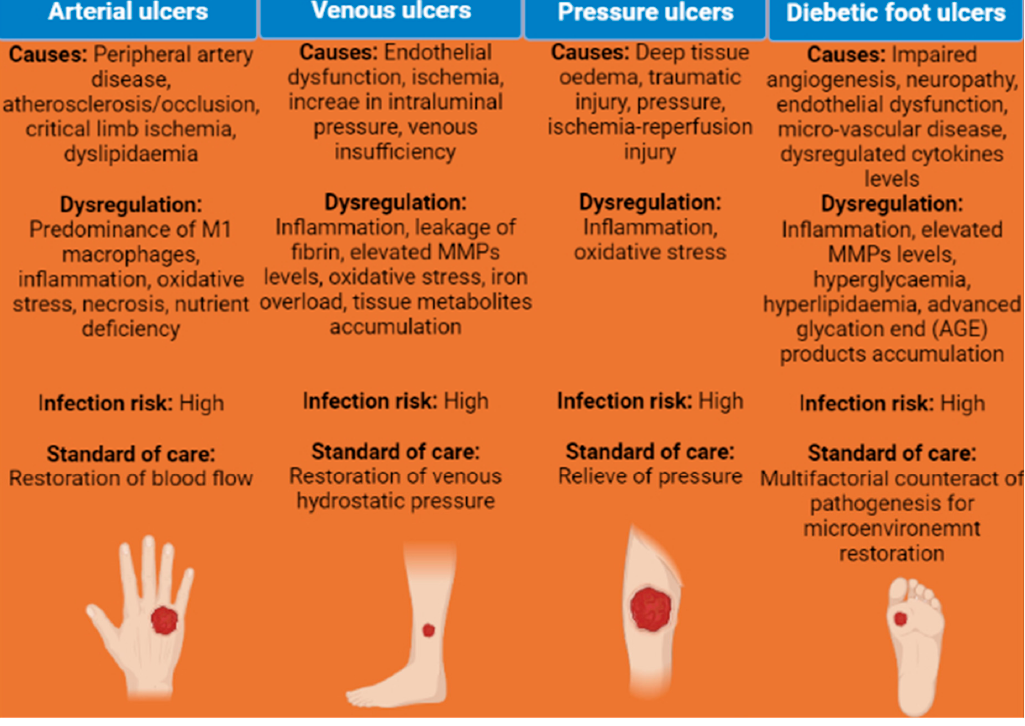
Figure 1. Etiology of different types of chronic wounds underlying causes, dysregulation, infection risk and standard of care.